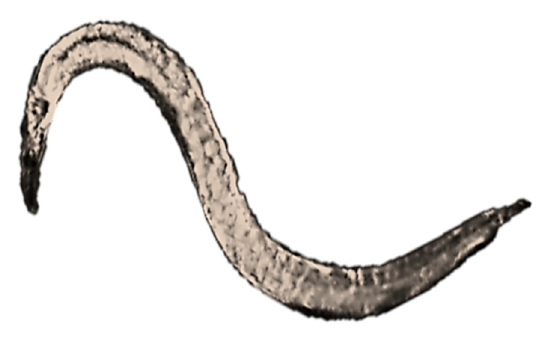
Figure 14. Example of nematode that can be used for ecotoxicity assessment.